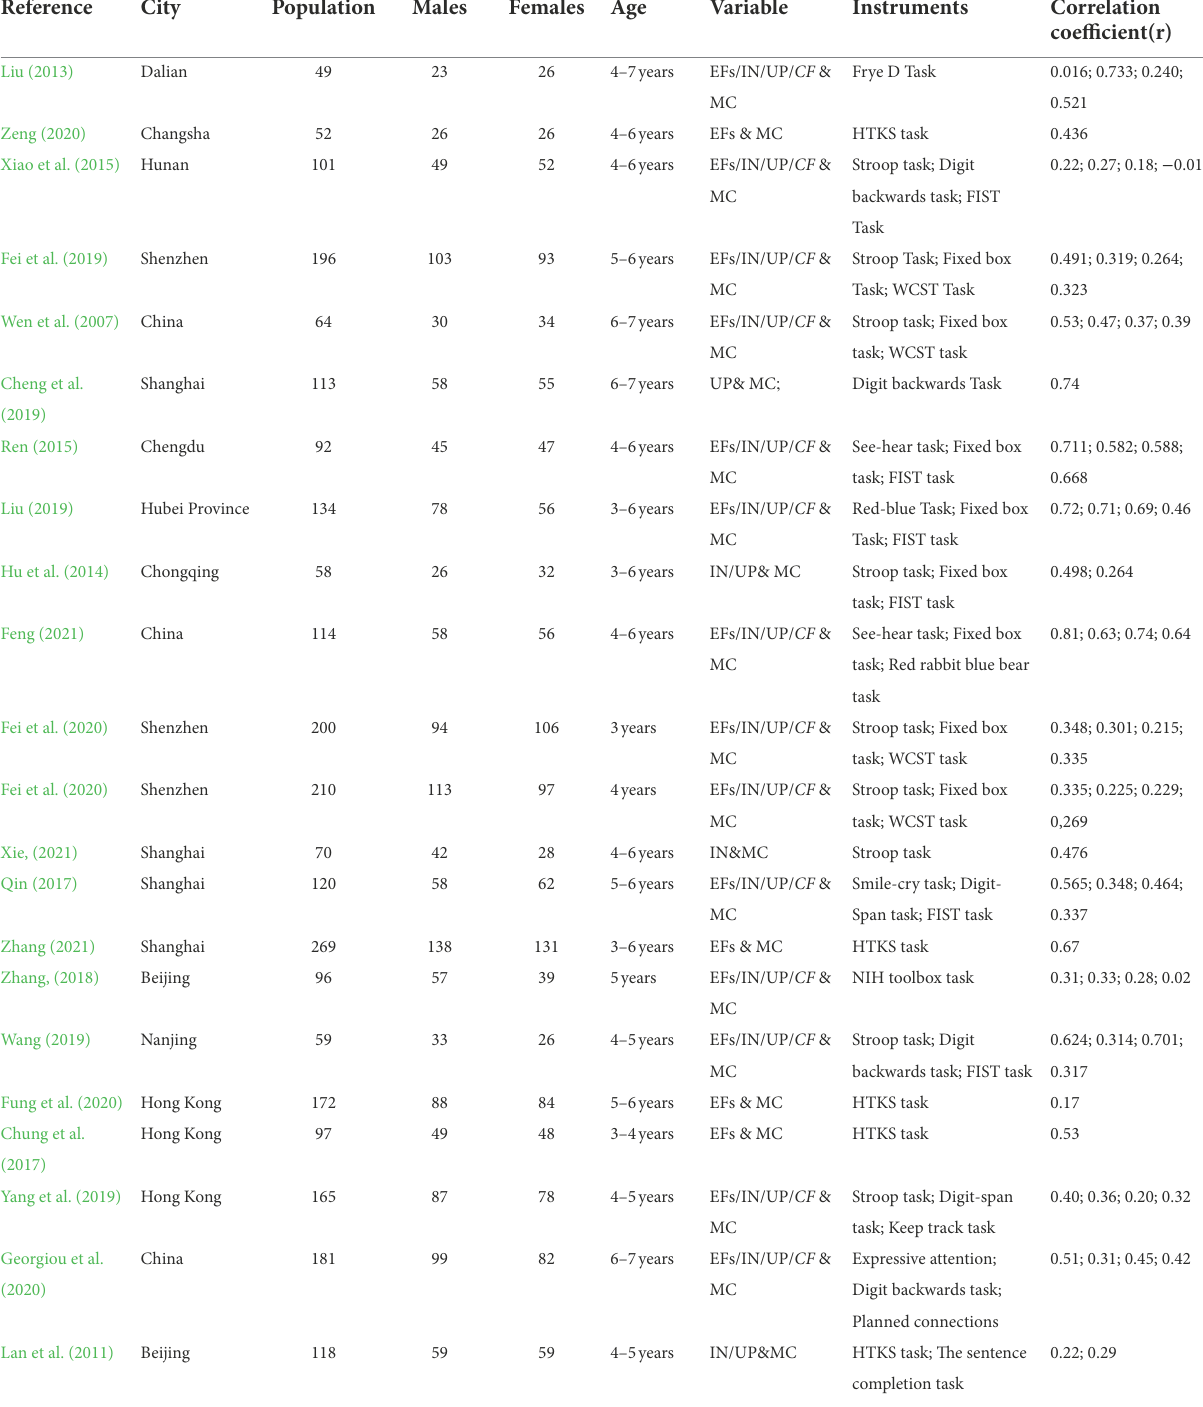
TABLE 1 Summary of studies included in the